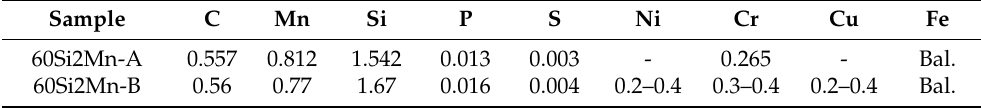
Table 1. Chemical composition of experimental steels (mass